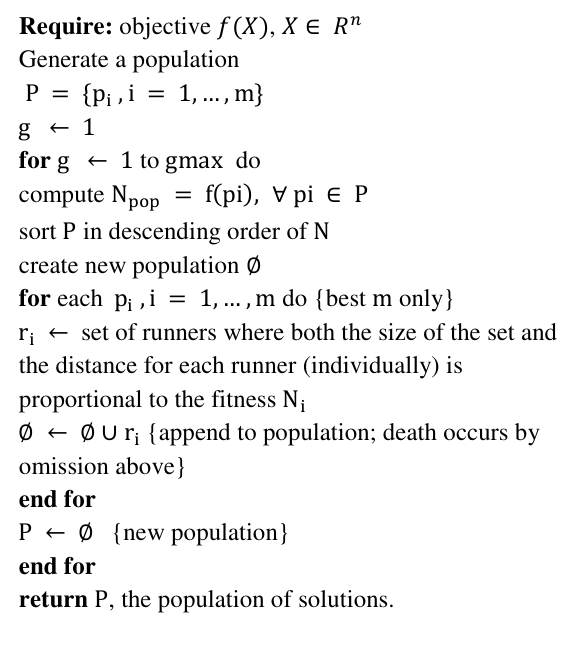
ALGORITHM 1: PSEUDOCODE OF PLANT PROPAGATION ALGORITHM